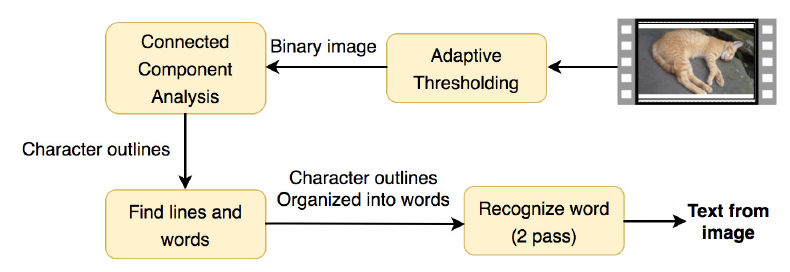
Figure 1. Tesseract recognition algorithm—OCR.